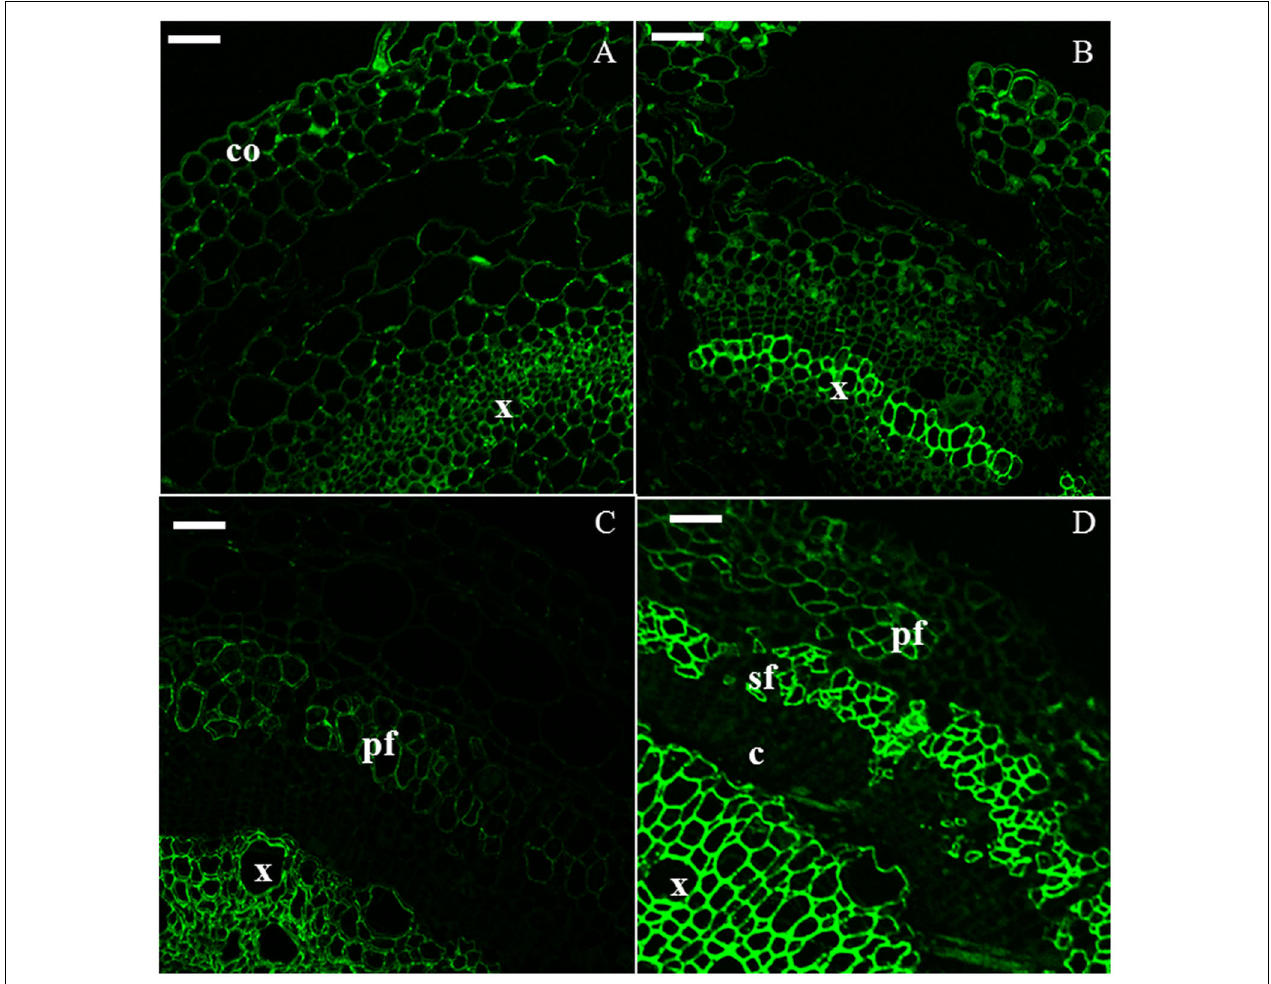
FIGURE 4 | Immunodetection of the LM10 epitope specific for xylan. H6 ( A , top left), H9 ( B , top right), H15 ( C , bottom left), H20 ( D , bottom right). c, cambium; co, collenchyma; pf, primary bast fiber; sf, secondary bast fiber; x, xylem. Scale bar: 50 µ